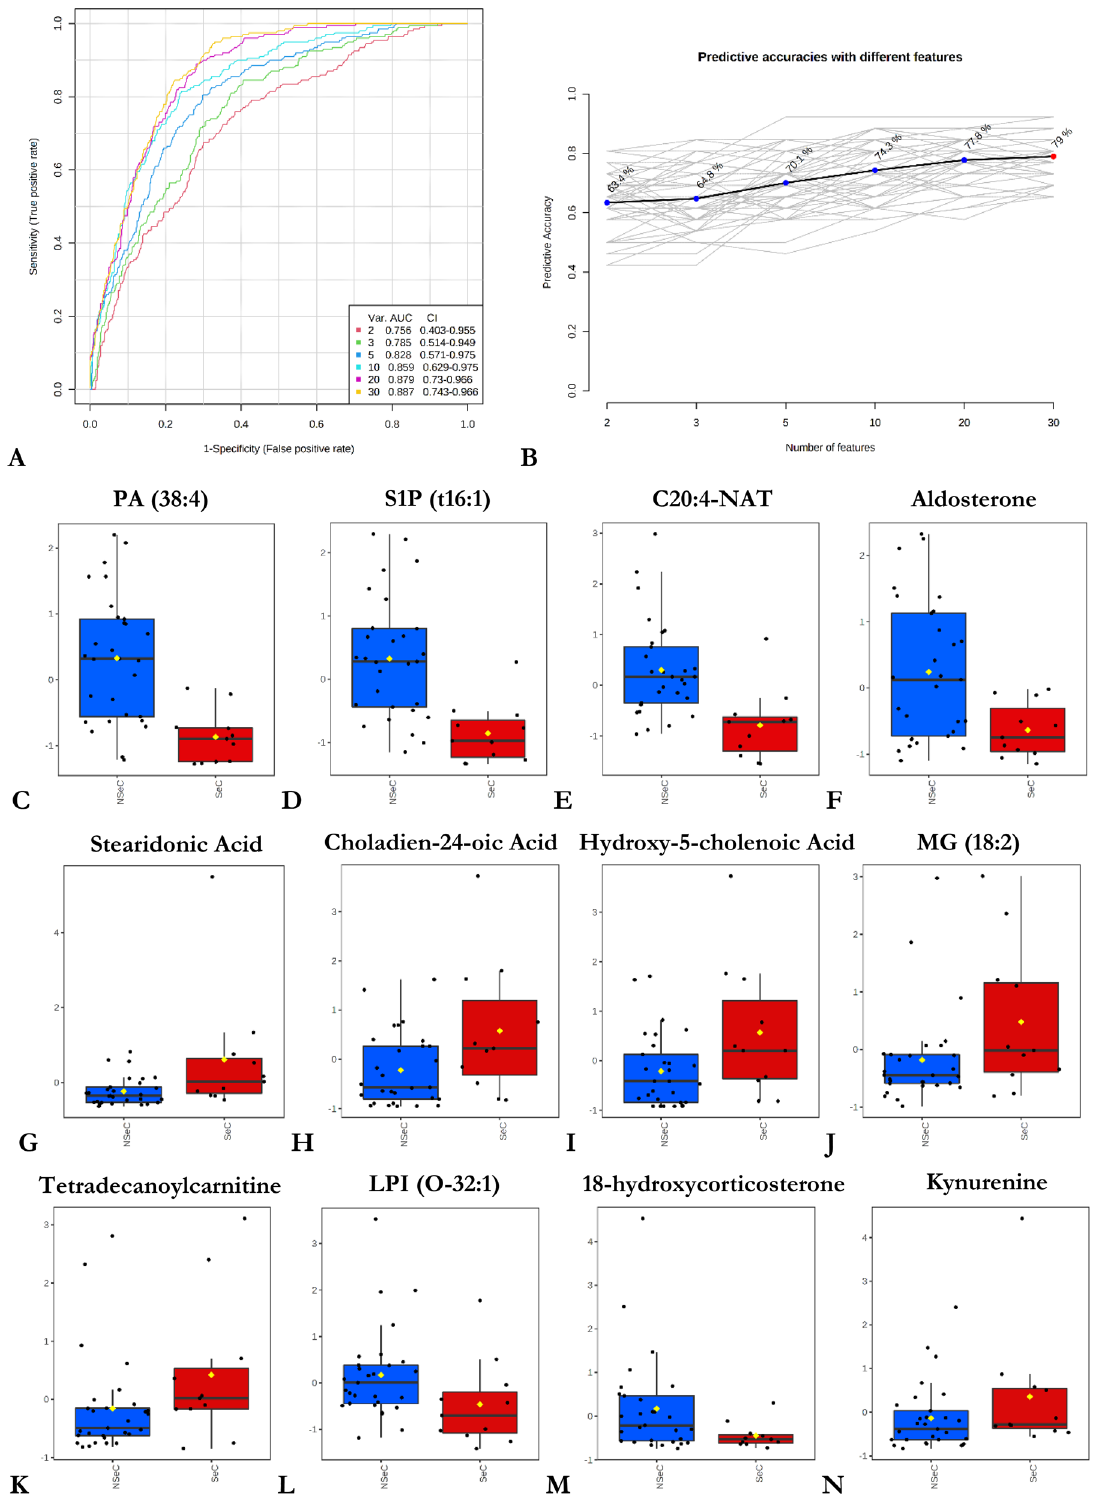
Figure 4. ROC curve analysis based on a multivariate PLS-DA algorithm for n = 30 independent metabolite features discriminating serous and non-serous carcinomas with VIP ≥ 2.0, and predictive accuracy model with a different number of features involved ( A , B ). Box whisker plots of the twelve most significant metabolites or lipids in the analysis of variance results for NSeC, non-serous carcinoma (NSeC, blue boxes) and serous carcinoma (SeC, red boxes). The x-axis depicts the specific metabolite/OC group, and the y-axis presents the normalized peak intensity ( C – N ). The lower, middle, and upper lines in the relevant box plots correspond to the 25th, 50th (the median), and 75th